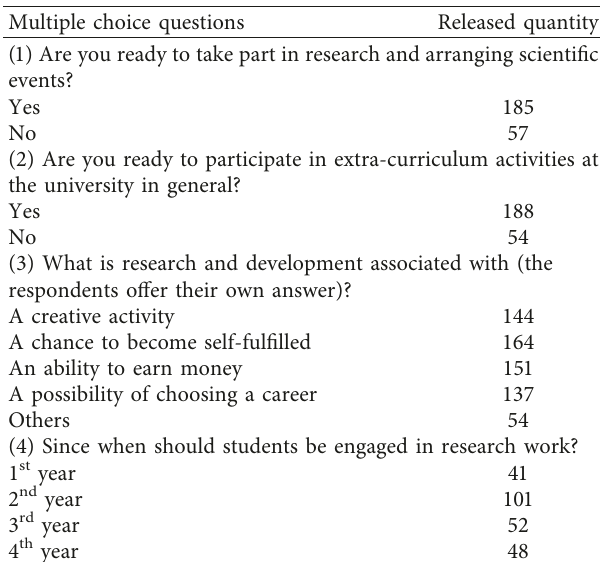
Table 1: Survey results of students that have completed The Basic Scientific Research